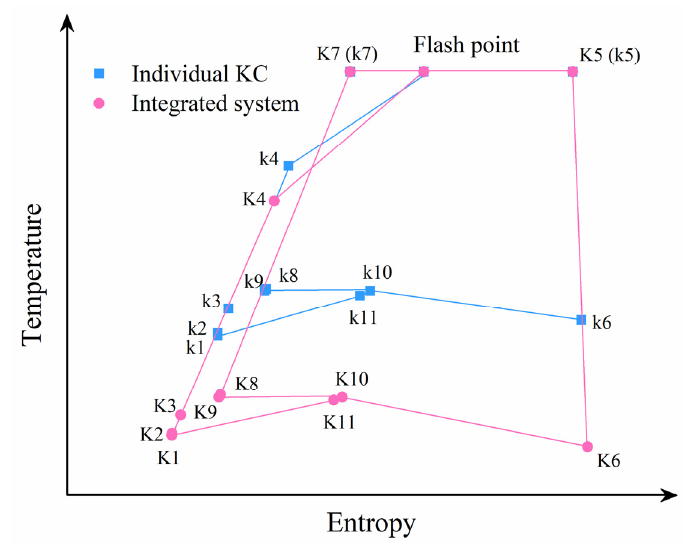
Figure 2. Temperature-entropy diagram of the integrated system and individual KC.